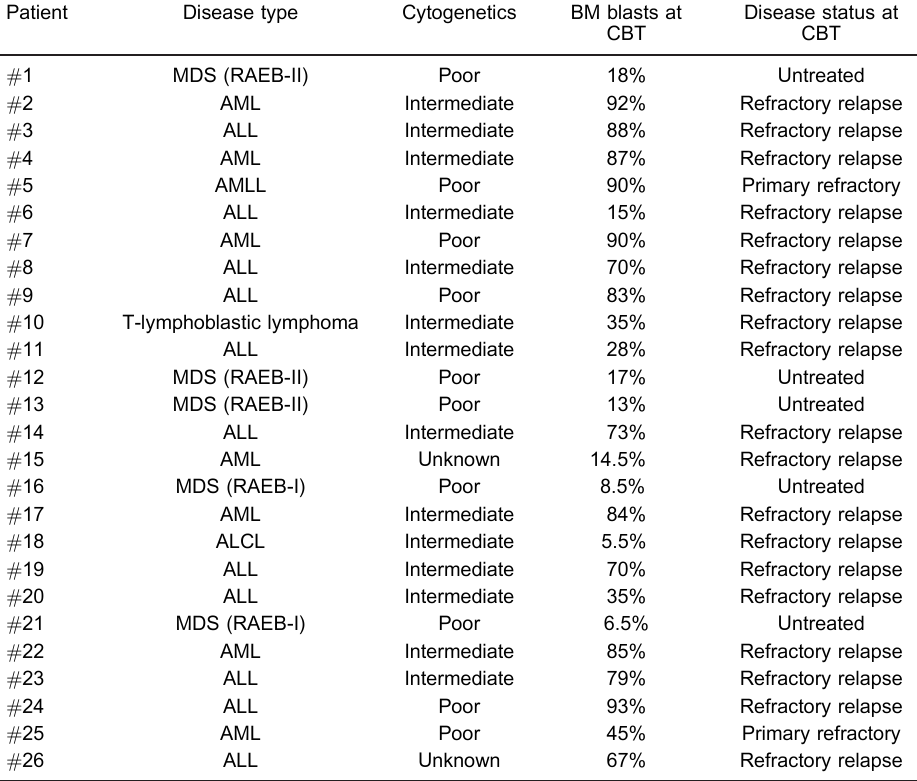
Table 2. Characteristics of each patient in